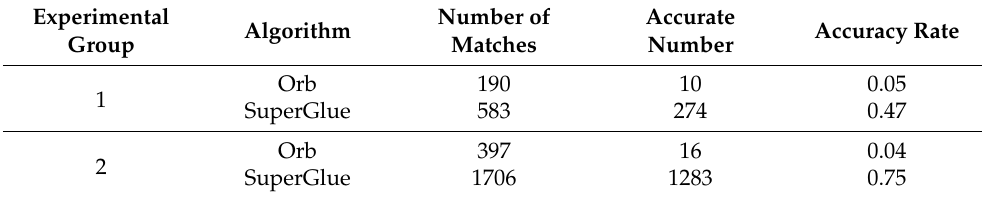
Table 1. Comparison of the algorithms’ matching